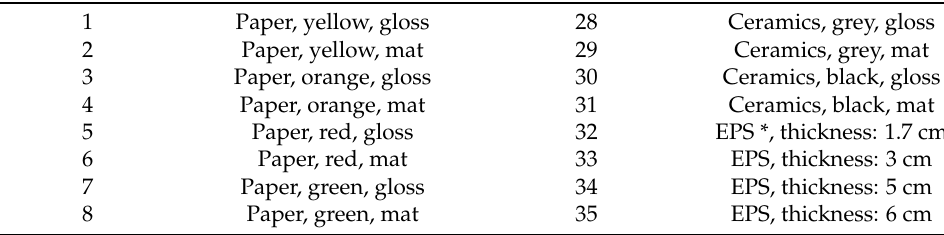
Table 1. The list of tested